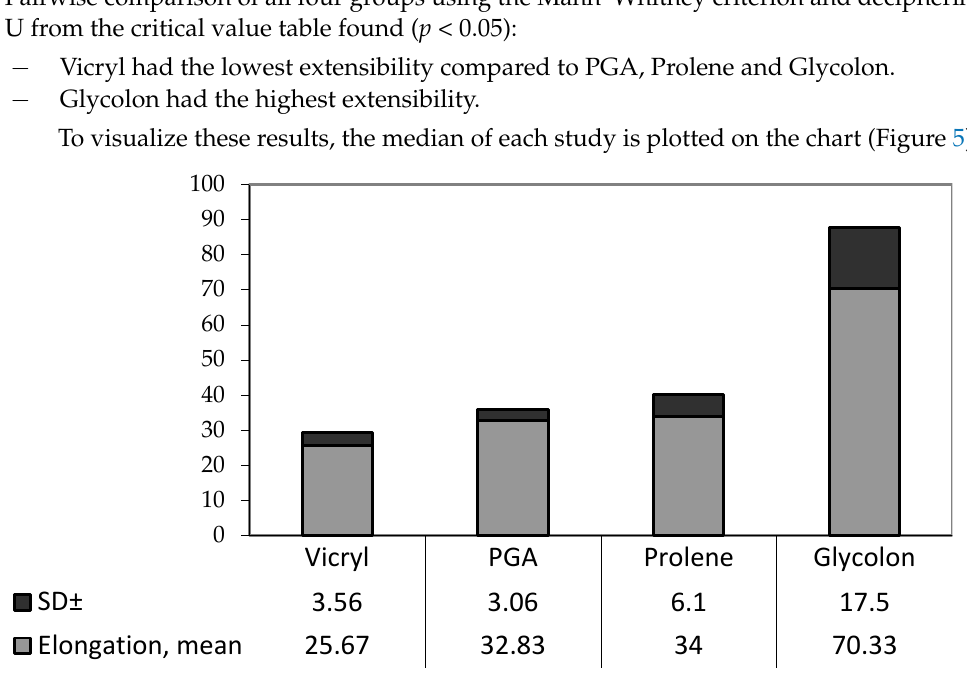
Figure 5. Diagram of the elongation of each material in mm (mean ± SD) .